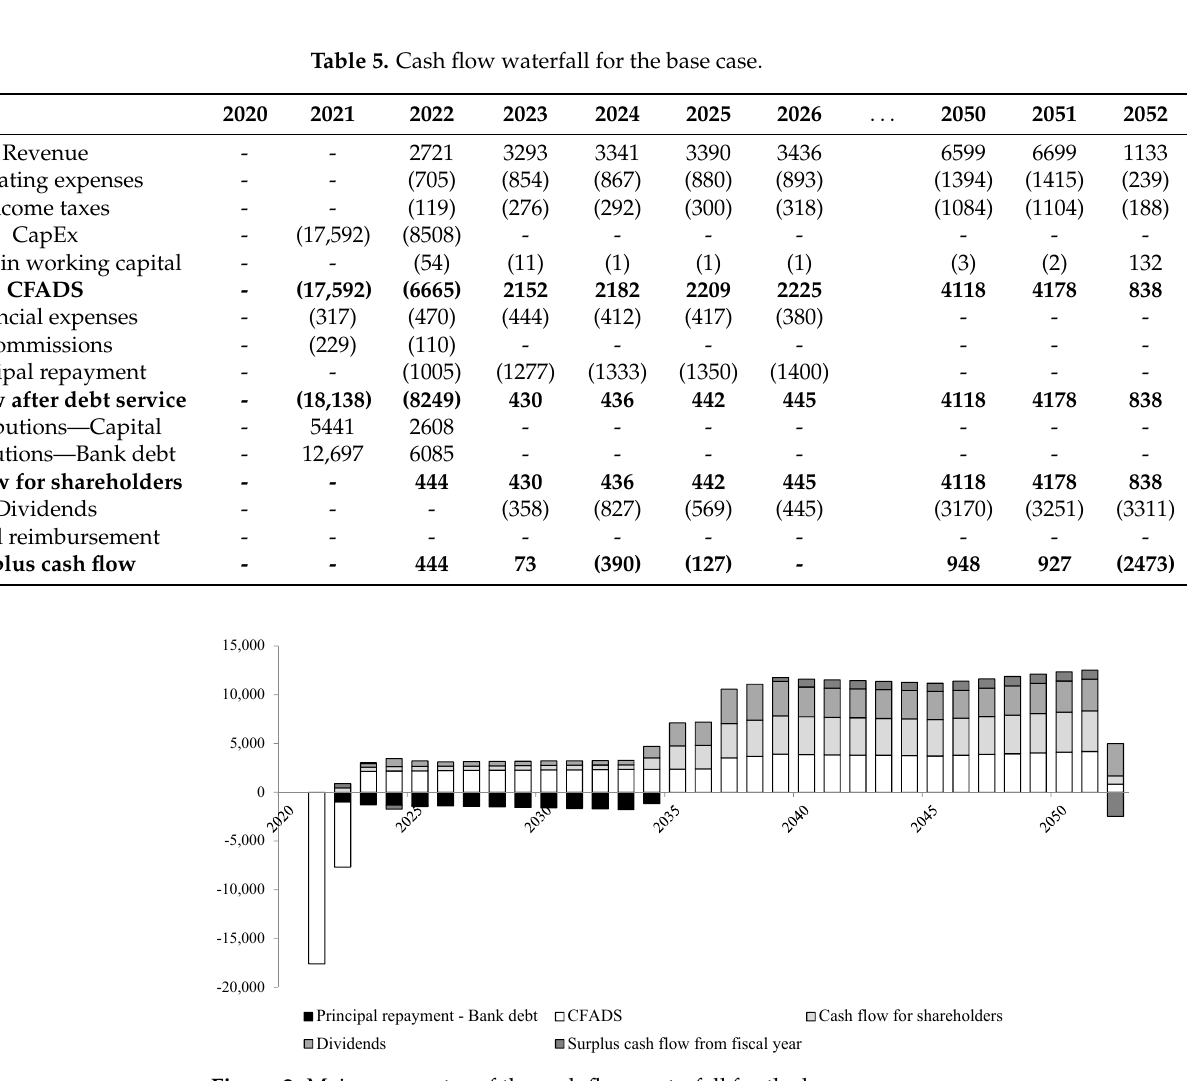
Figure 2. Main aggregates of the cash flow waterfall for the base case. Based on the projections shown in Table 5 for equity contributions and the dividends paid to shareholders, Table 6 shows the detail of the calculations used to determine the implied cost of equity of the project considering a time-varying discount